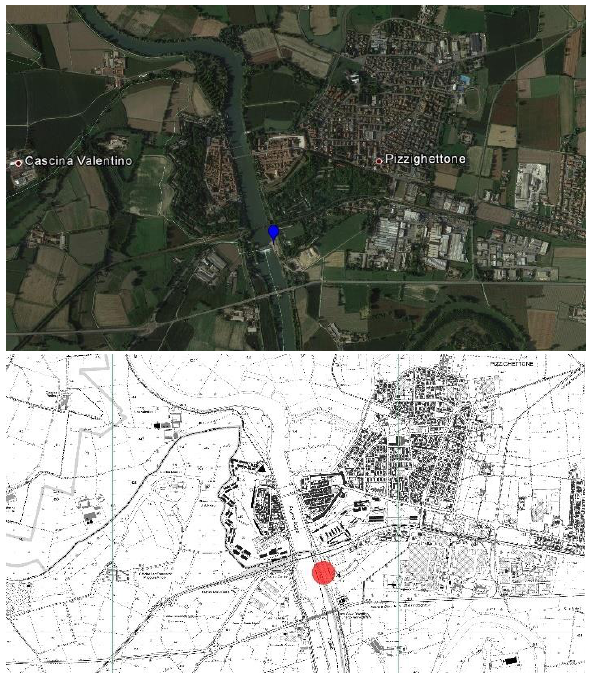
Figure 2. Above: view from Google Earth of the site on the Adda river. Below: site georeferenced on technical map.